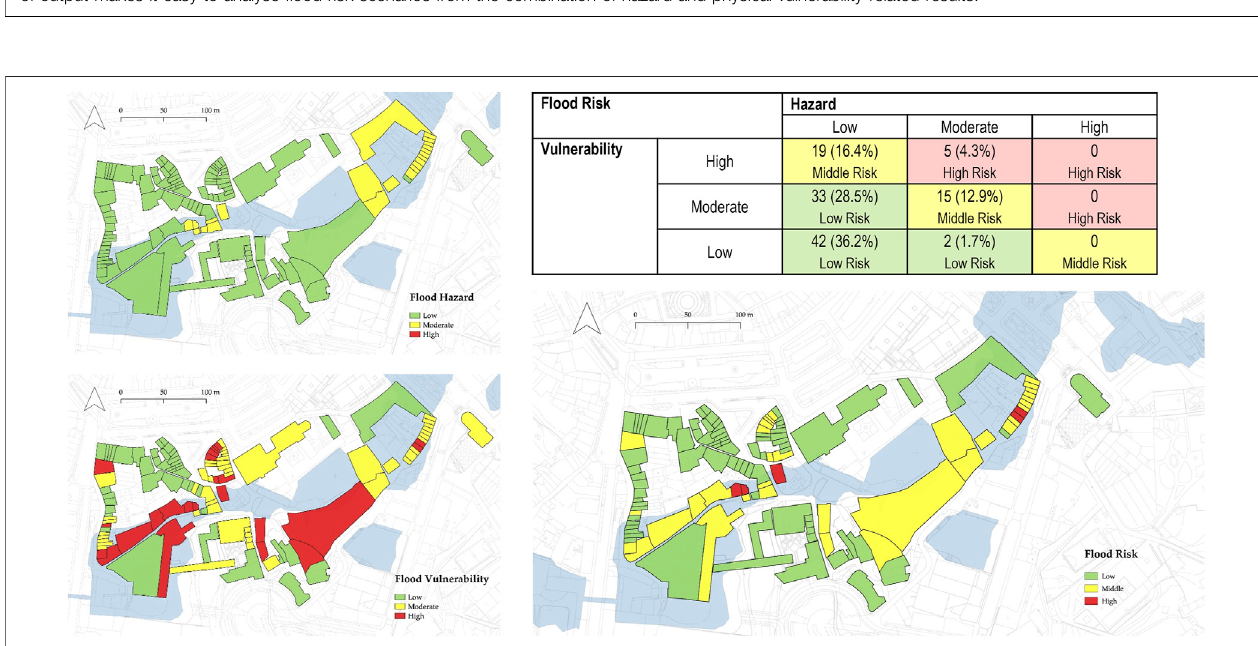
FIGURE 11 | Example of a fl ood risk matrix based on the combination of the level of Hazard and Vulnerability obtained for each building. The numbers and the percentages included in the tables represent the number and percentage of buildings categorised with that speci fi c level of risk.